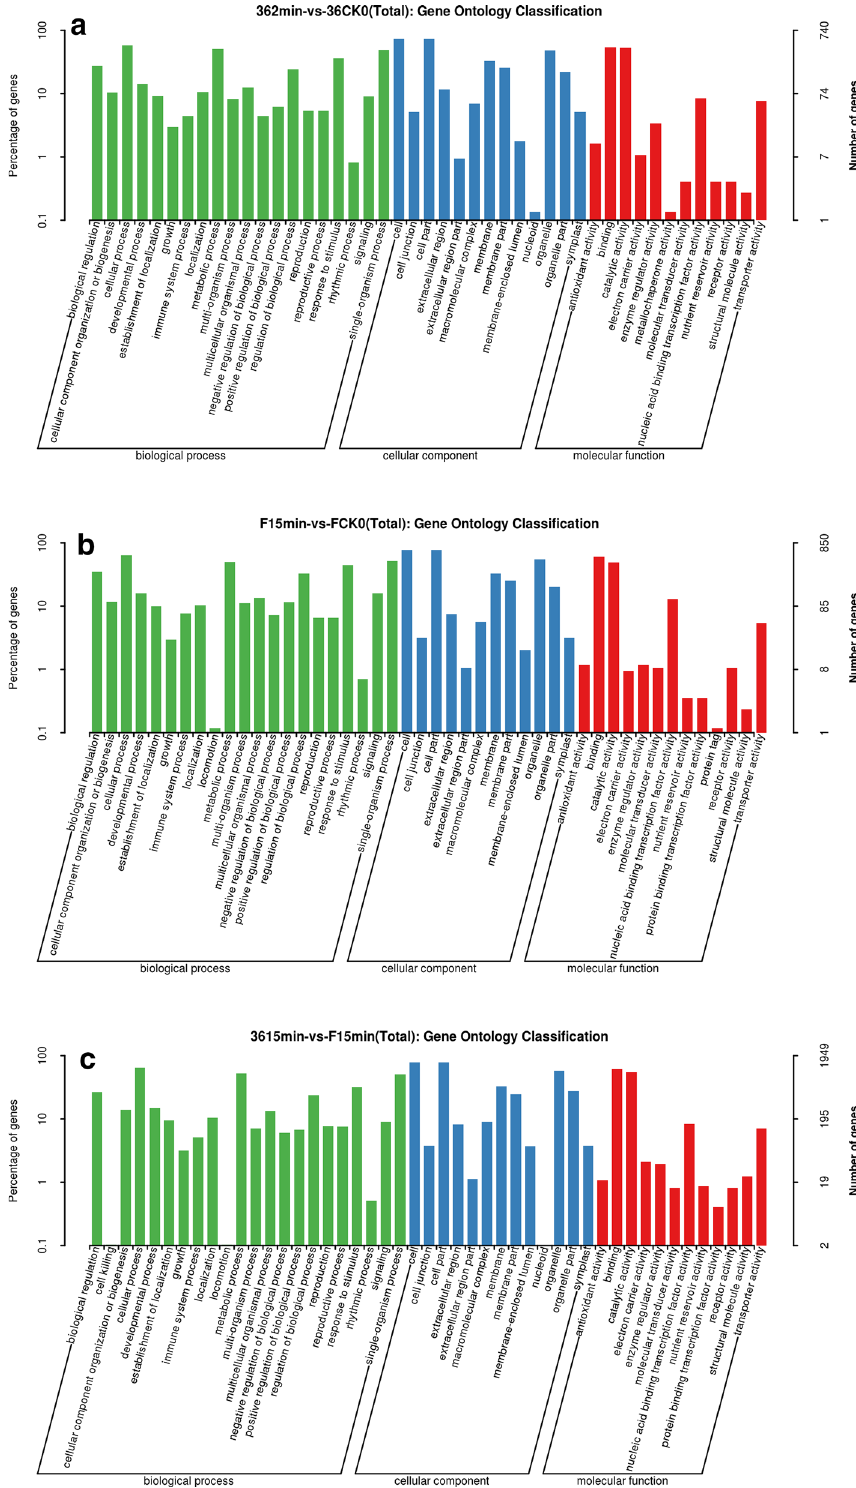
Figure 4. ( a ) GO functional enrichment of the ‘36’ 2 min vs ‘36’ CK0 groups. ( b ) GO functional enrichment of the ‘F’ 15 min vs ‘F’ CK0 groups. ( c ) GO functional enrichment of the ‘36’ 15 min vs ‘F’ 15 min groups. The figures was drawn with DEseq (v3.5.1). (http:// www. bioco nduct or. org/ packa ges/3. 8/ bioc/ html/ DESeq.